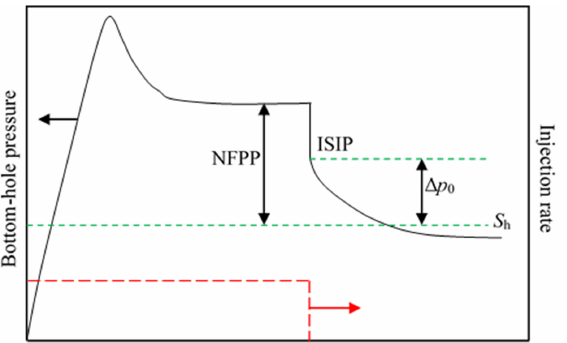
Figure 1. The schematic of the pressure response for the hydraulic fracture treatment. (NFPP—net fracture propagation pressure; ISIP—instantaneous shut-in pressure; S h —closing stress; Δ p 0 —net fracture pressure.).